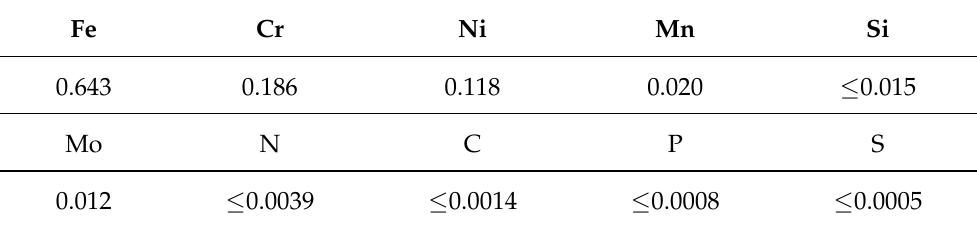
Table 1. Composition of the Ni- and Cr-Rich AISI-316L by Atom Fractions X